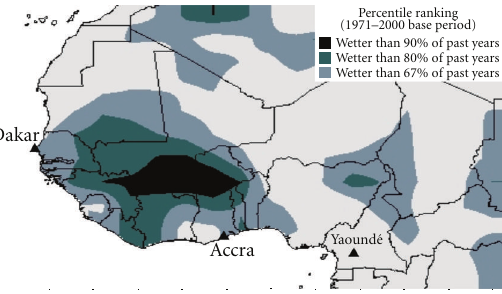
Figure 4: Observed rains and location of stocks prepositioned by IFRC in June–August 2008, represented by triangles (source: